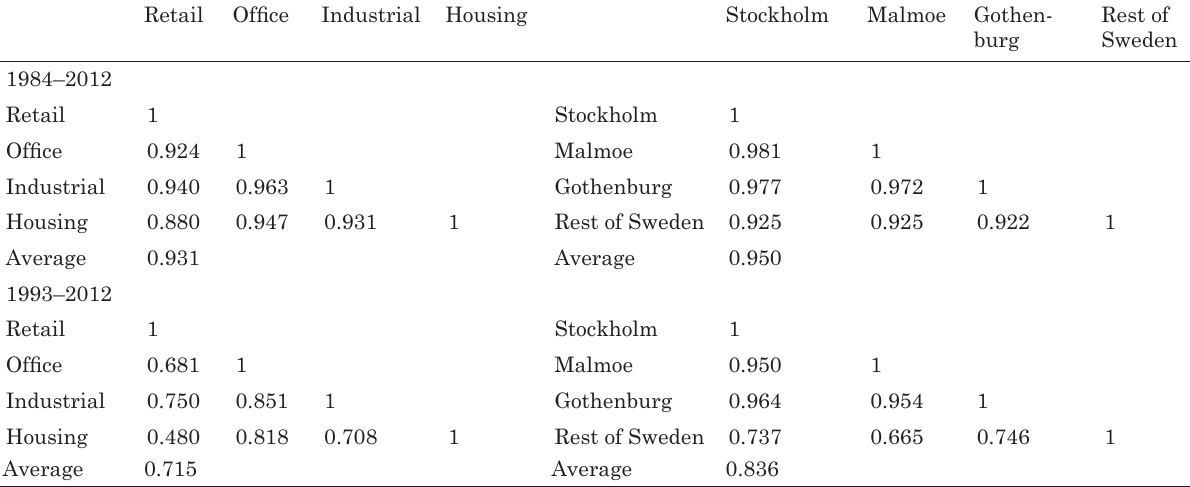
Table 5. Cross correlations of value weighted returns for property types and